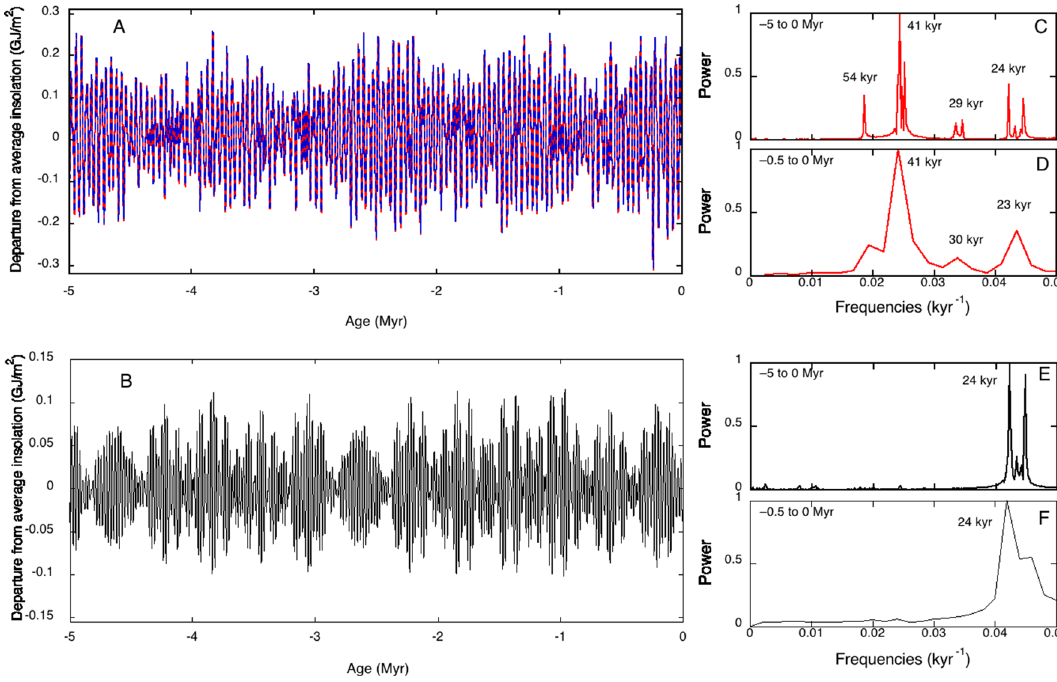
Figure 1. ( A ) Changes in summer energies at 65°N above the insolation threshold of 275 W/m 2 relative to average (ca. 5 GJ/cm 2 17 , centered in zero, red line), and corresponding Fourier series (blue dashed line). ( B ) Changes in solar energy received at 25°N in the month of March relative to average (ca. 1 GJ/cm 2 , centered in zero) 18,19 . Corresponding frequency distributions calculated for the time interval from – 5 Myr to present ( C , E ), or for the last 500 kyr ( D , F